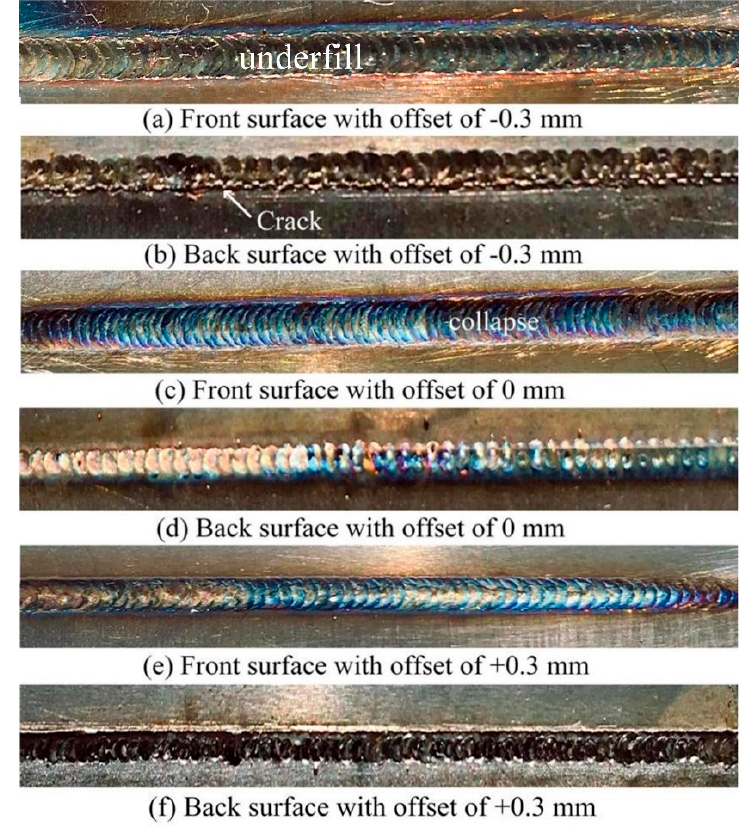
Figure 2. Surface morphologies of 301L/TA2 welded joints with different offsets: ( a , c , e ) front surface with offset of − 0.3 mm, 0 mm and +0.3 mm, respectively; ( b , d , f ) back surface with offset of − 0.3 mm, 0 mm and +0.3 mm, respectively.